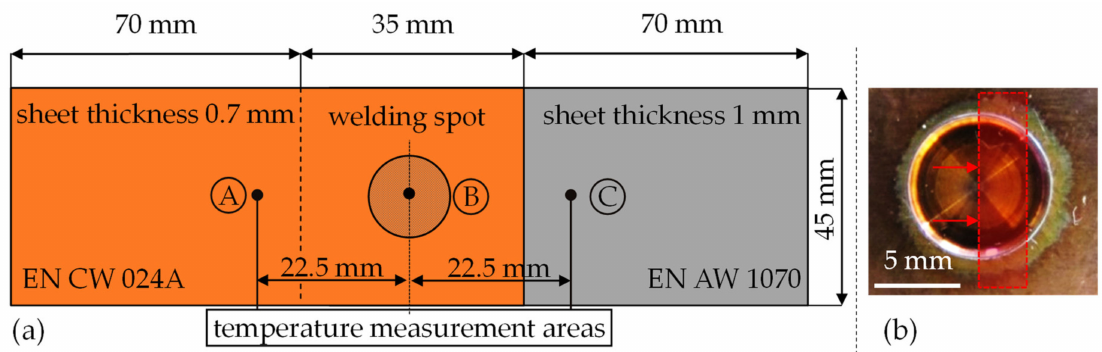
Figure 3. Geometry and configuration of the weld specimens with temperature measurement areas ( a ) and weld cut- out with marked section region for metallographic sample ( b ). The measurement areas for the temperature were at the Al–Cu-interface (B), at a distance of 22.5 mm from the welding spot middle in copper (A) and aluminum (C).